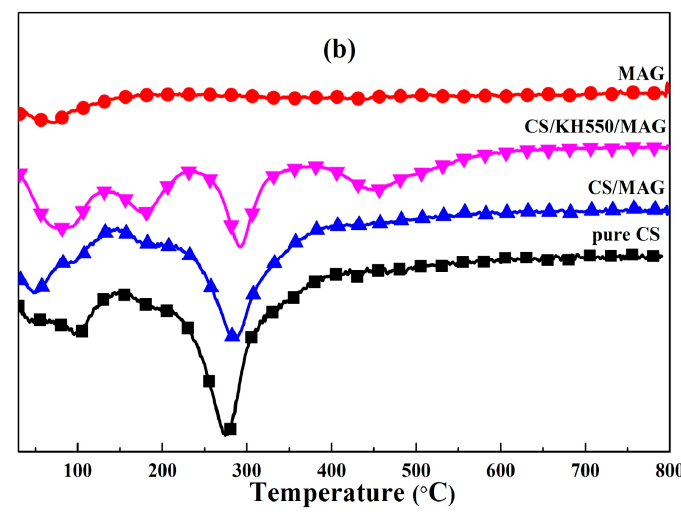
Figure 7. ( a ) Thermal gravimetric (DTG) and ( b ) differential thermal gravimetric (DTG) curves of MAG, pure CS, CS/MAG, and CS/KH550/MAG hybrid membranes.